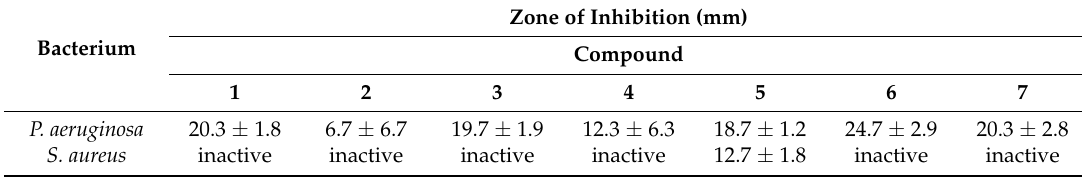
Table 2. Antimicrobial activity of seven flavonoids [3,4 (cid:48) ,5,7-tetrahydroxyflavanone ( 1 ), 3 (cid:48) ,4 (cid:48) ,5,7- tetrahydroxyflavanone ( 2 ), 4 (cid:48) ,5,7-trihydroxyflavanone ( 3 ), 3,4 (cid:48) ,5-trihydroxy-7-methoxyflavanone ( 4 ), (+)-(2S)-4 (cid:48) ,5,7-trihydroxy-6-methylflavanone ( 5 ), 4 (cid:48) ,5,7-trihydroxy-6,8-dimethylflavanone ( 6 ),